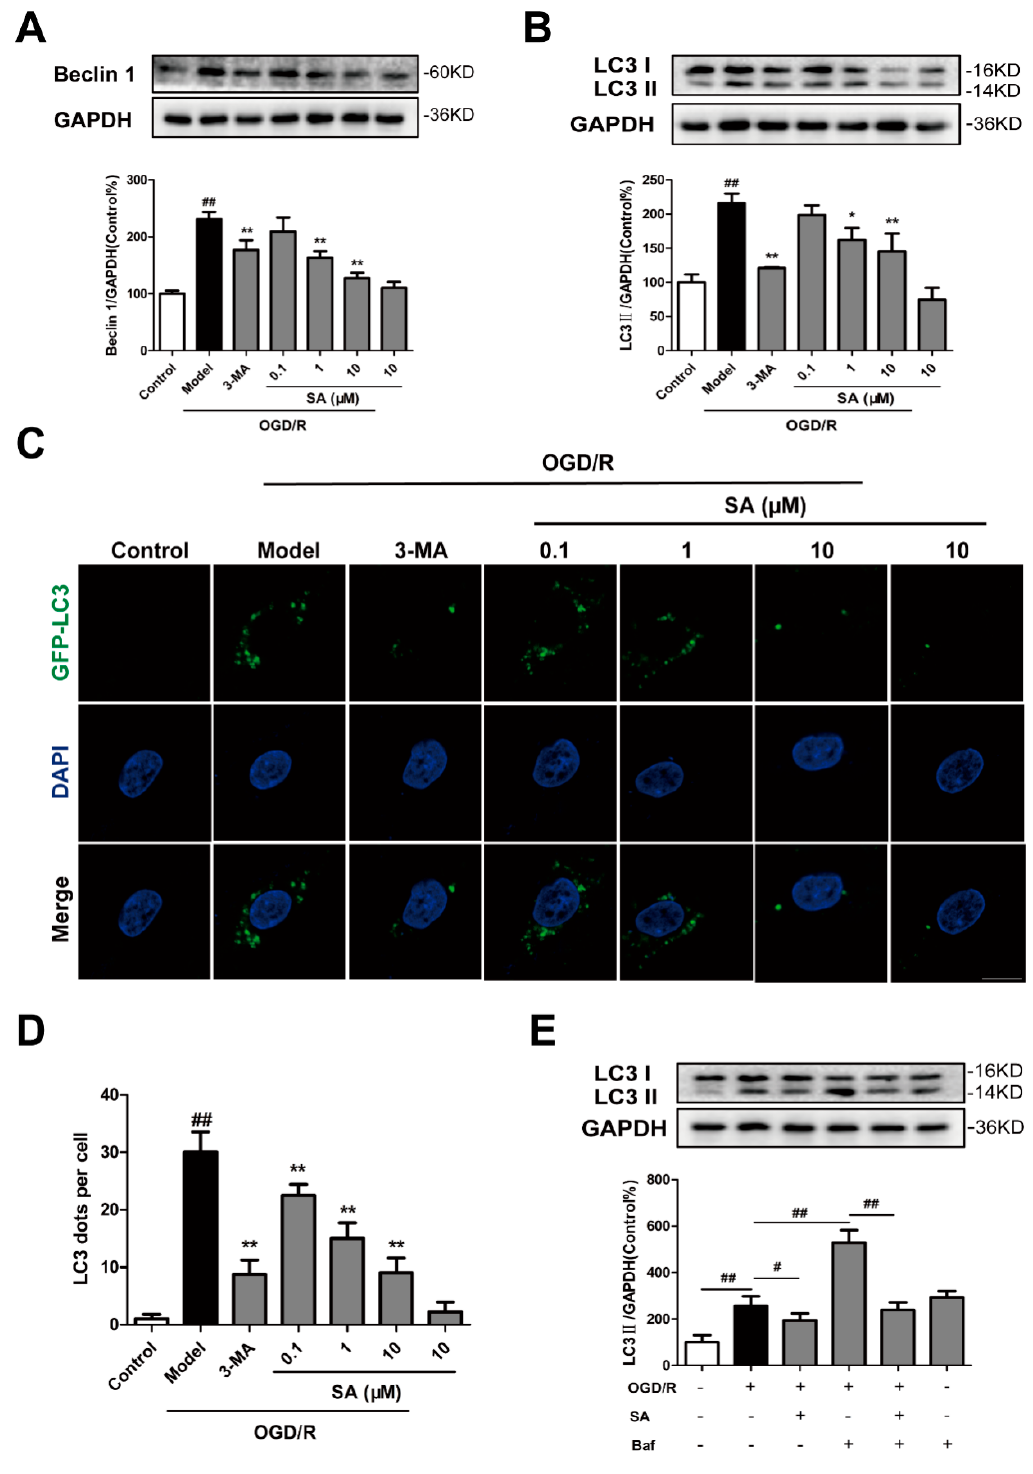
Figure 2. SA inhibits autophagy following OGD / R in PC12 cells. PC12 cells were pretreated with SA and exposed to OGD / R. The expression of Beclin 1 ( A ) and LC3 ( B ) was detected by Western blot (n = 3). ( C ) LC3-positive puncta in cells were detected by GFP-LC3 plasmid transfection. Scale bar: 10 µ m. ( D ) The number of LC3 puncta in PC12 cells were calculated (n = 4). ## P < 0.01 vs. control group; * P < 0.05 and ** P < 0.01 vs. model group. ( E ) PC12 cells were treated with Baf combined with SA, and cell lysates were prepared for analyzing the LC3 expression (n = 3). # P < 0.05 and ## P < 0.01.